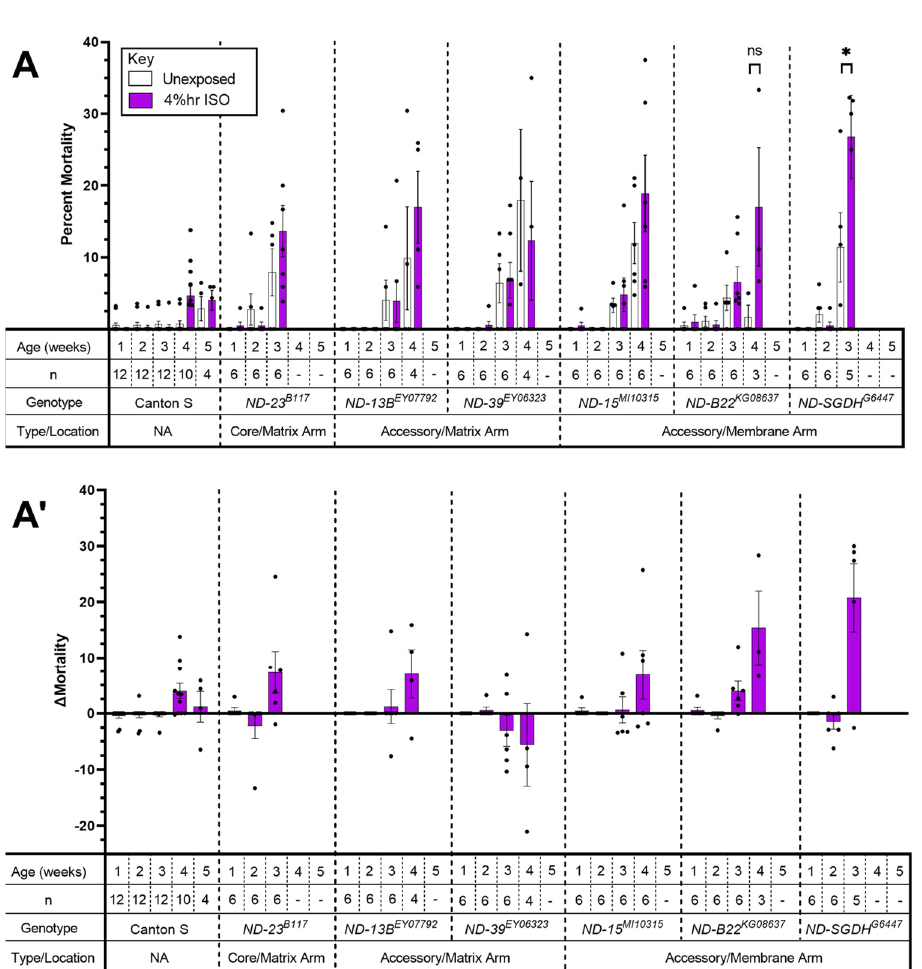
Figure 3. Complex I subunits screen identifies an ND-SGDH mutant as AiN susceptible. ( A ). Flies were exposed for two hours to 2% ISO in 75% O 2 at weekly intervals beginning at one week of age. After exposure, they were returned to standard culture vials. Dead flies were counted and survivors were transferred to fresh vials 24 h after exposure. Mutations in Complex I subunits carried variable age-dependent mortality due to natural attrition (white bars). The increase in mortality after hyperoxic ISO reached significance only for ND-SGDH G6447 at three weeks old. ( A’ ). Data from A, control mortality subtracted ( ∆ Mortality). (Week 1 = 1–6 days old; Week 2 = 8–13 days old; Week 3 = 15–20 days old; Week 4 = 22–27 days old; Week 5 = 29–34 days old.) Each dot represents a biological replicate of 15–30 mixed-sex flies. Results are presented as mean ± SEM. ns: not significant, *: p < 0.05 Dashes indicate that the experiment was not performed because there were fewer than three vials of 15 flies.